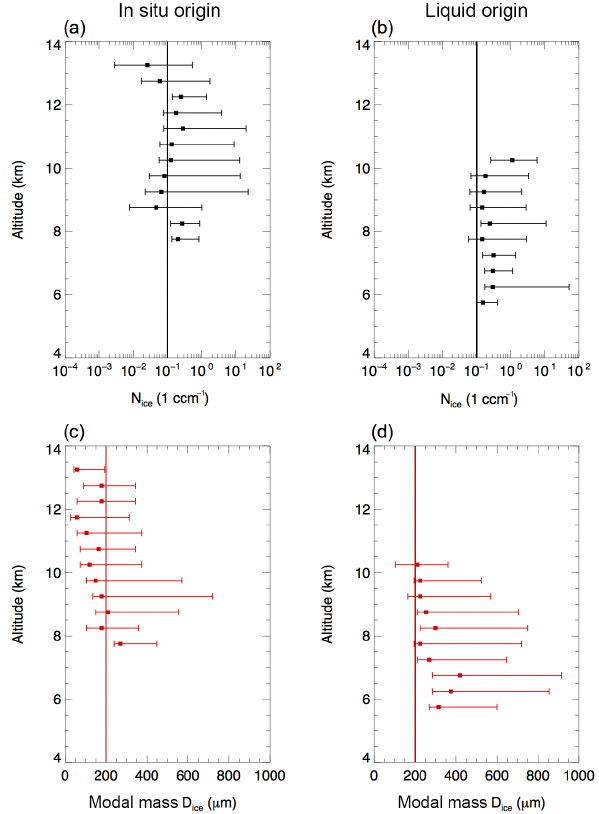
Figure 9. Vertical profiles of median values of N ice (a, b) and D ice, mode (c, d) for in situ origin (a, c) and liquid origin (b, d) cirrus. The horizontal bars represent the range from the lower quar- tile to the upper quartile. The black, vertical line at 0.1cm − 3 in a and b represents the modal N ice observed in midlatitude cirrus. The red, vertical line at 200µm in c and d was arbitrarily chosen as a ref- erence for comparing the D ice, mode